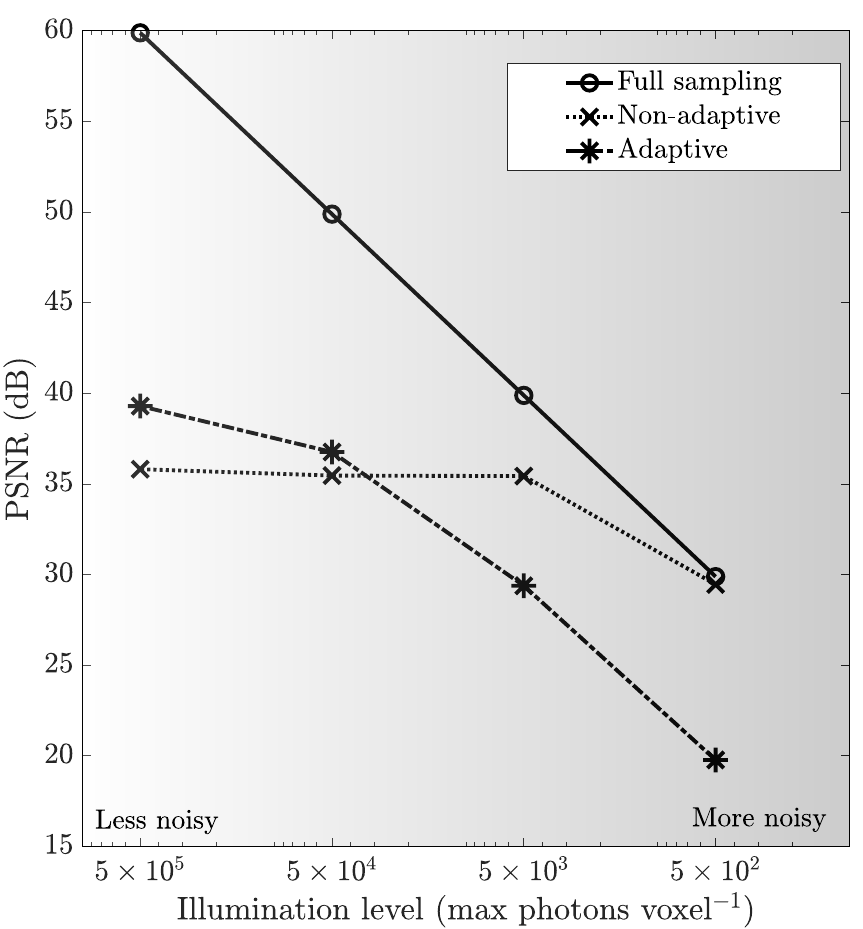
Figure 5. The effect of the illumination level on the reconstructed image PSNR of the U2OS cell scene for multitrack full sampling, multitrack non-adaptive CS and multitrack adaptive CS. The illumination level (horizontal axis) decreases from left to right, corresponding to an increasing prominence of shot noise. The gray shading illustrates the illumination level. The dark current α is fixed at